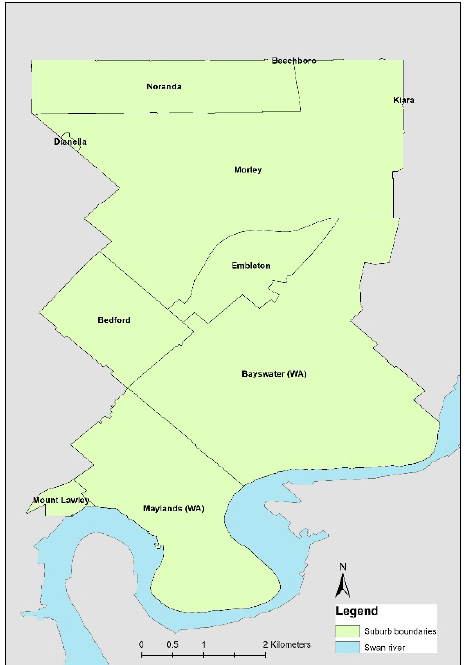
Figure 2. Location and administrative boundary of City of Bayswater [34]. Map is prepared from open-source data (Acknowledgement: Australian Bureau of Statistics and Department of Biodiversity, Conservation and Attractions)